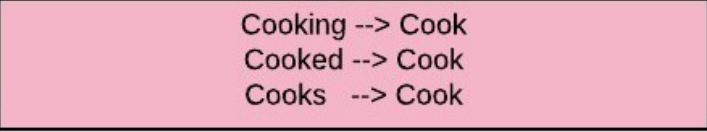
Figure 7. Word Stemming